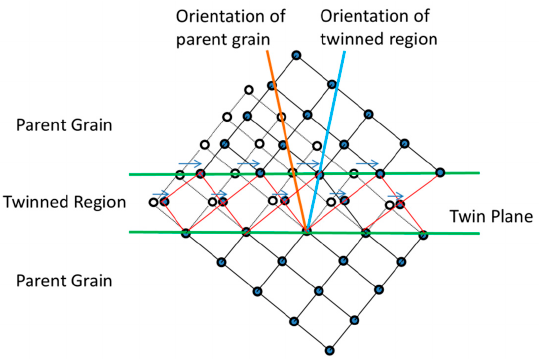
Figure 6. The crystallographic description of extension twinning (After Yaghoobi et al. [103]).